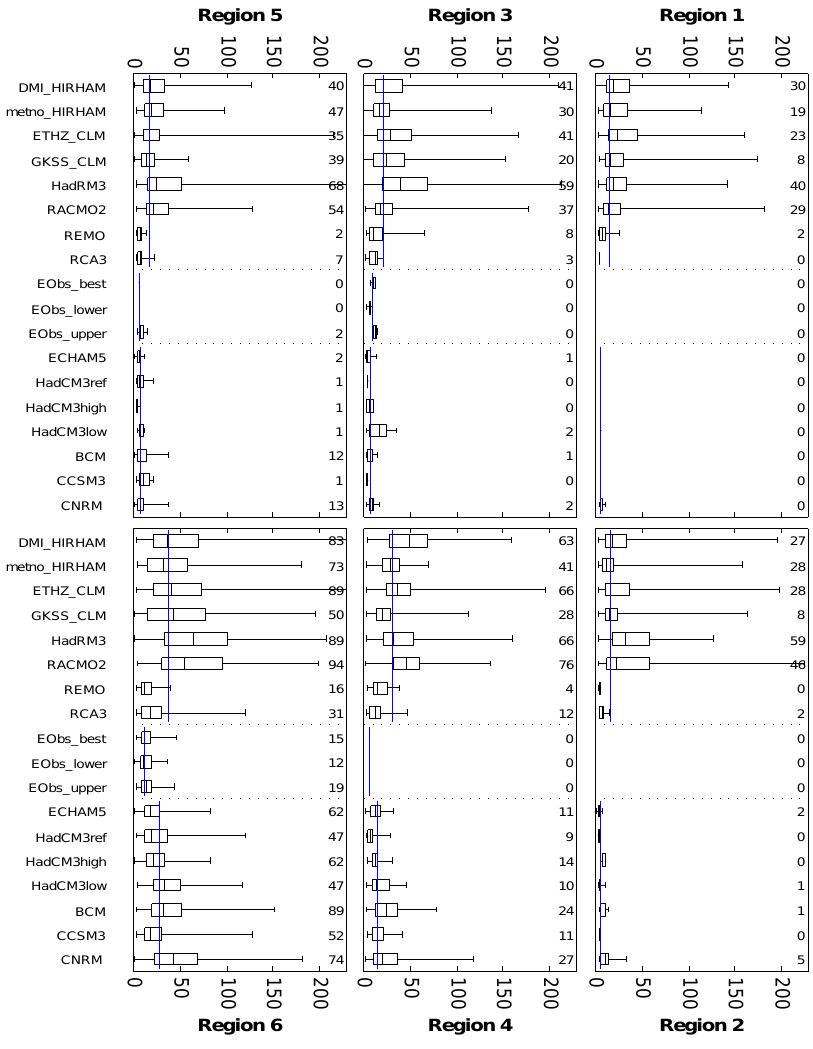
Fig. 4. Spring backlash index, units are degree-days. The organisation and layout of the graphs is the same as for Fig. 3.